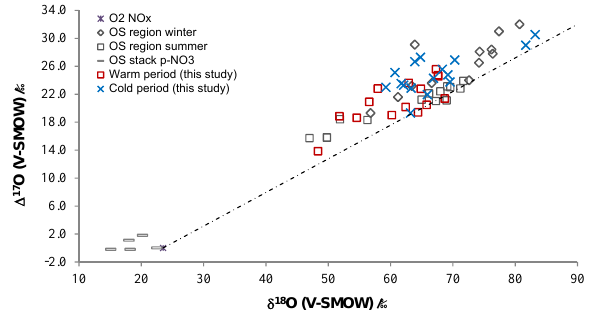
Figure 6. Isotopic ratios for atmospheric p NO − samples in cold and warm periods from central and southern Alberta (this study), compared with previously published winter and sum- mer bulk and throughfall deposition samples from the oil sands (OS) region from northern Alberta (Proemse et al., 2013), and p NO − stack emissions data for an OS upgrader located in the same region (Proemse et al., 2012). The grey dotted line connects NO x from the- oretical combustion with O 2 isotopic composition and at isotopic equilibrium with tropospheric O 3 (Michalski et al.,